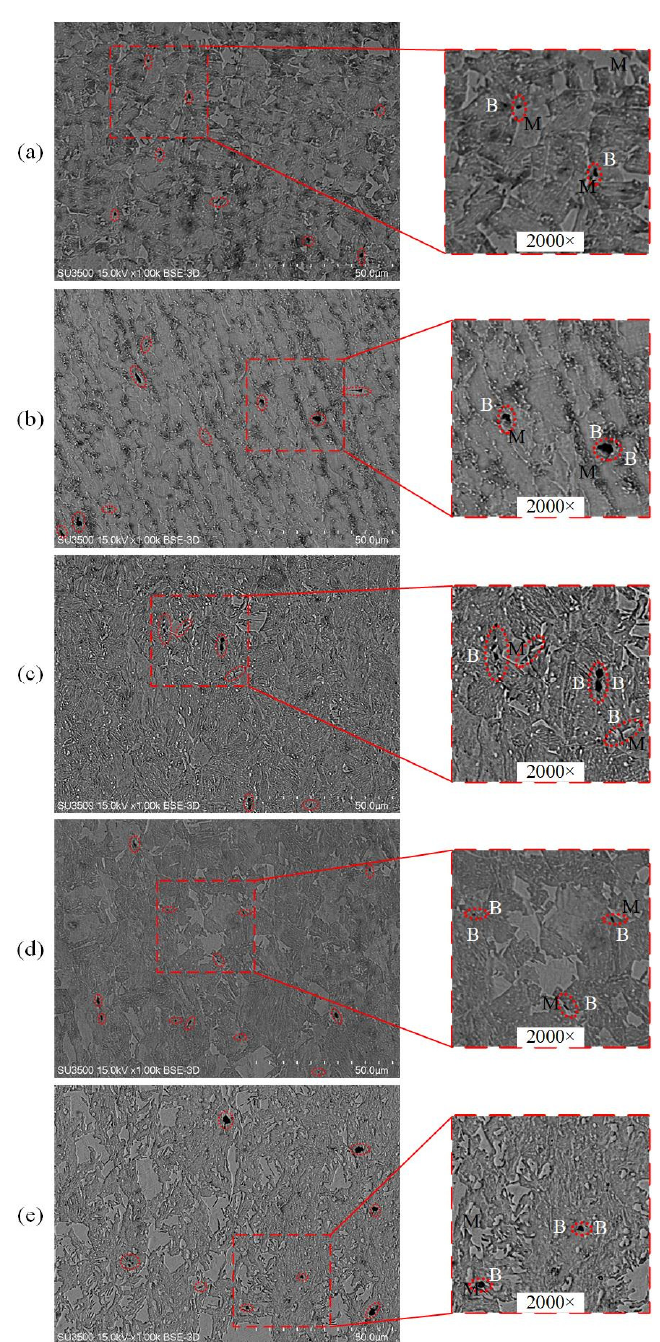
Figure 22. SEM micrographs showing void initiation and crack growth for 80%B + 20%M specimens under varying stress states: ( a ) pure shear specimen; ( b ) dogbone uniaxial tension specimen; ( c ) uniaxial tension specimen with a central hole; ( d ) plane strain tension specimen; ( e ) equi-biaxial tension specimen.